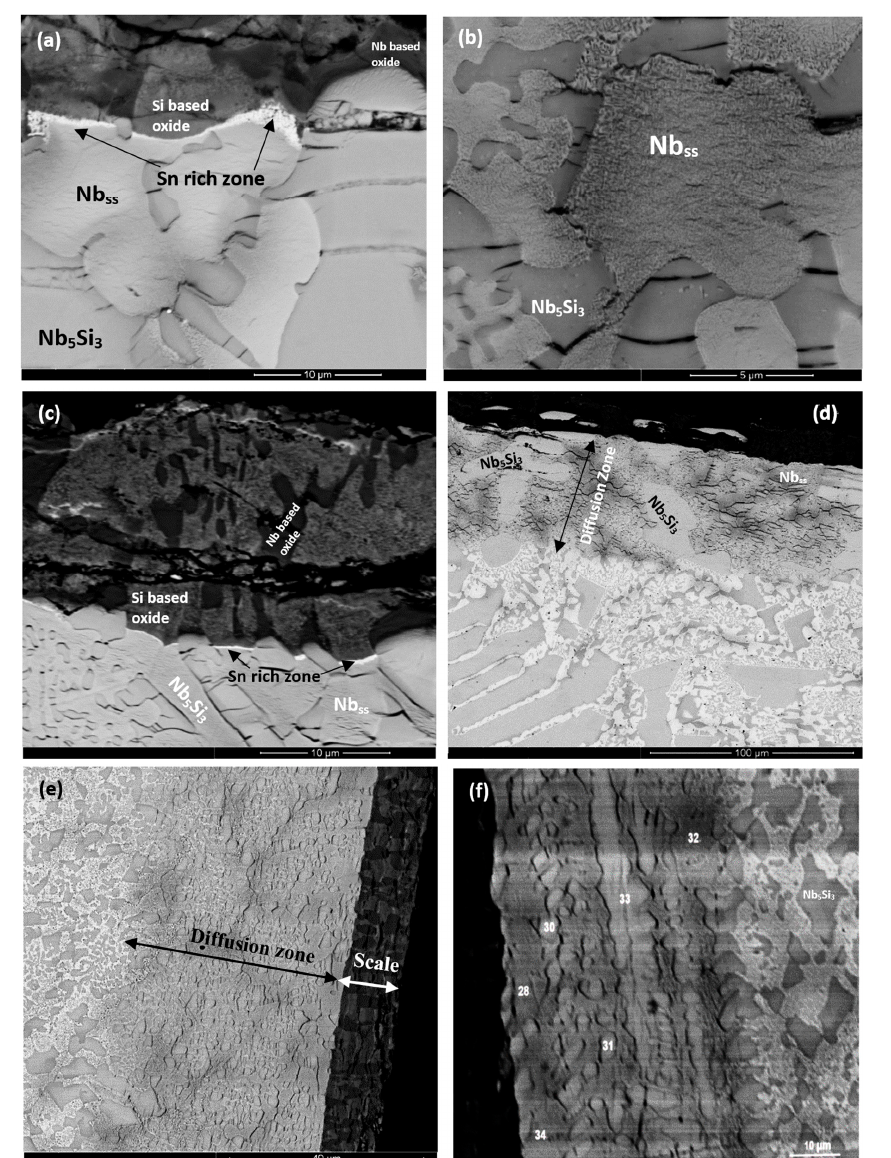
Figure 4. BSE images of cross-sections of the alloys ZX3 ( a , b ), ZX5 ( c , d ), and ZX7 ( e , f ) after isothermal oxidation for 100 h at 800 ◦ C. The numbers in ( f ) link with the WDS analysis data in Table S7 in Supplemental data.